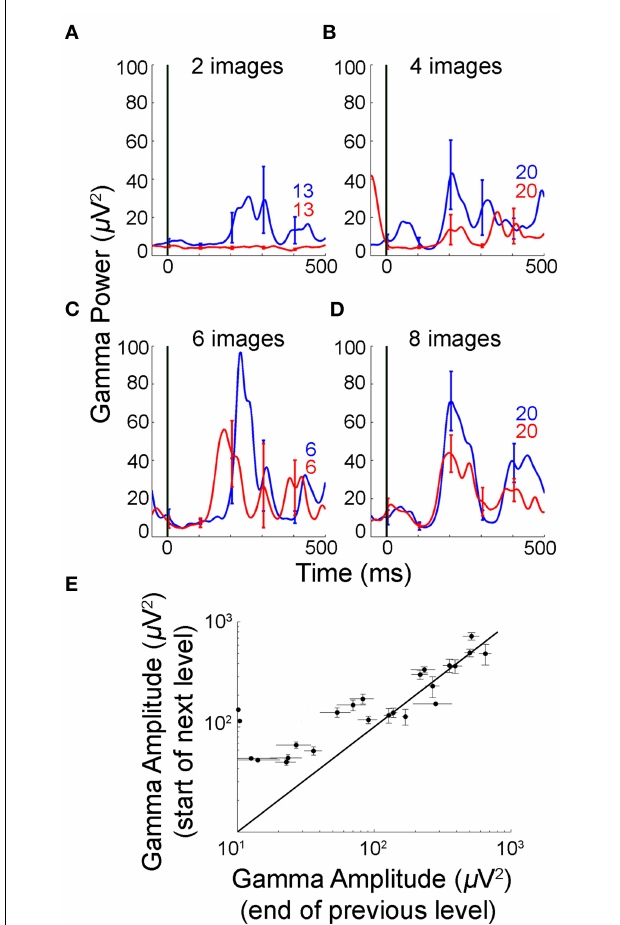
FIGURE 6 | Gamma frequency band amplitude was reset at the start of each level in Task 2. (A–D) Mean gamma frequency band power averaged over early and late trials in multiple levels for the same electrode in Figures 5B,C (numbers of trials shown in each subplot). The subject participated in a single experimental session consisting of four levels of increasing sequence length. The interval between levels ranged from 8 to 183s. The maximum performance in any bin of 10 trials was 100% in level 1 (27 trials), 100% in level 2 (96 trials), 80% in level 3 (13 trials), and 70% in level 4 (80 trials). The mean gamma frequency band amplitude decreased significantly between “early” and “late” trials within levels 1, 2, and 4 as the sequences were learned ( p < 0 . 01, rank sum test). Level 3 had a small number of trials since the subject learned the sequences rapidly and significance was not reached even though the trend is the same as in the other levels. The mean gamma frequency band amplitude did not continue to decrease across levels but instead was reset to a new and higher value. (E) Gamma frequency band amplitudes in the last 20 trials for the previous level (x-axis) vs. first 20 trials in the next level (y-axis) during the recall phase This figure includes N = 3 out of four subjects that reached the learning criterion in Task 2 and participated in at least two levels with ≥ 20 trials. The diagonal represents no change in gamma frequency band amplitudes between the last 20 trials of the preceding level and the first 20 trials in the next level. Error bars represent